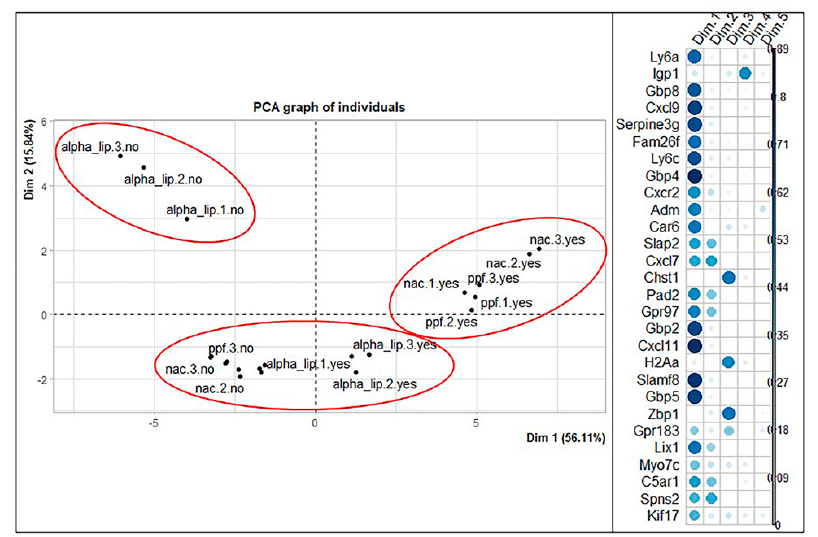
Figure 8. Representation of the distribution of samples in the new coordinate system obtained through the PCA technique for BV2 cell line. Correlation plot shows how much a gene contributes to each dimension of the new coordinate system. alpha_lip: α -lipoic acid; nac: N-acetyl-cystein; ppf: propentofylline; yes/no: presence/absence of active principle treatment; 1/2/3: replicates.